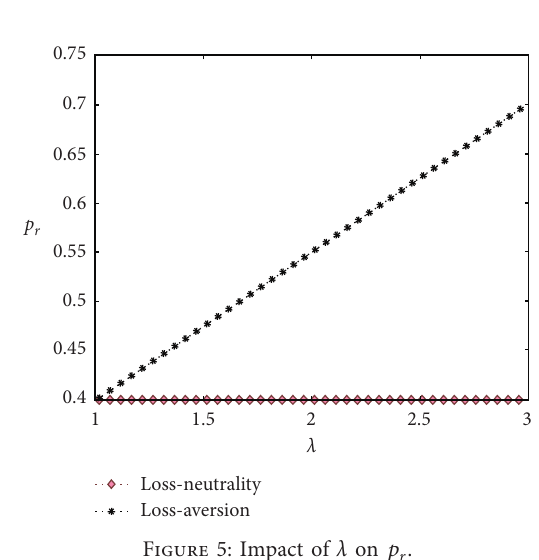
Figure 5: Impact of λ on p